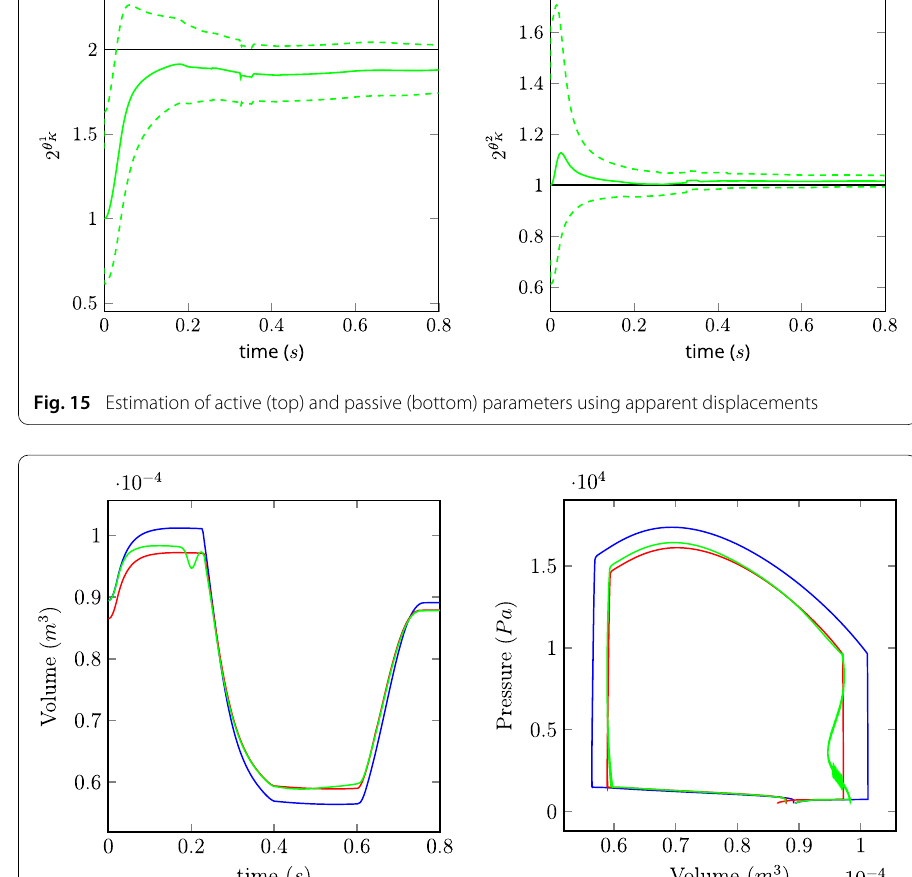
Fig. 16 Time evolution of the volume and P-V loop for the observer (in (green)) using tag planes (with coarse time sampling of the observations) compared with the healthy direct model (in (blue)) and the reference infarcted model (in